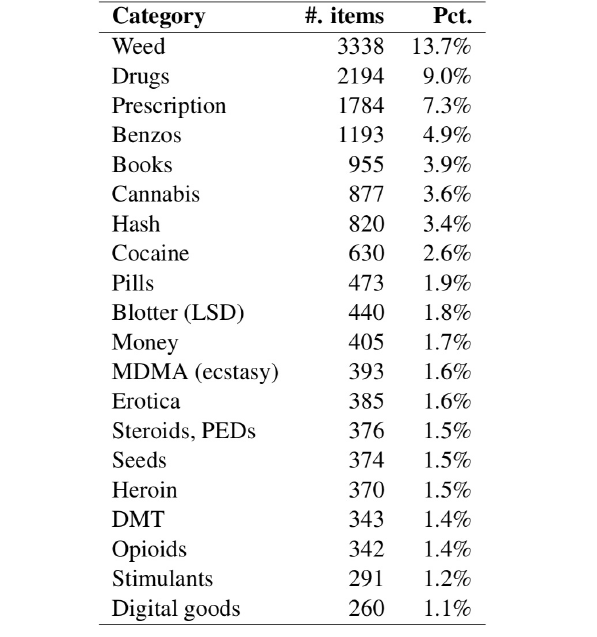
FIGURE 2 | Top 20 product categories of items available